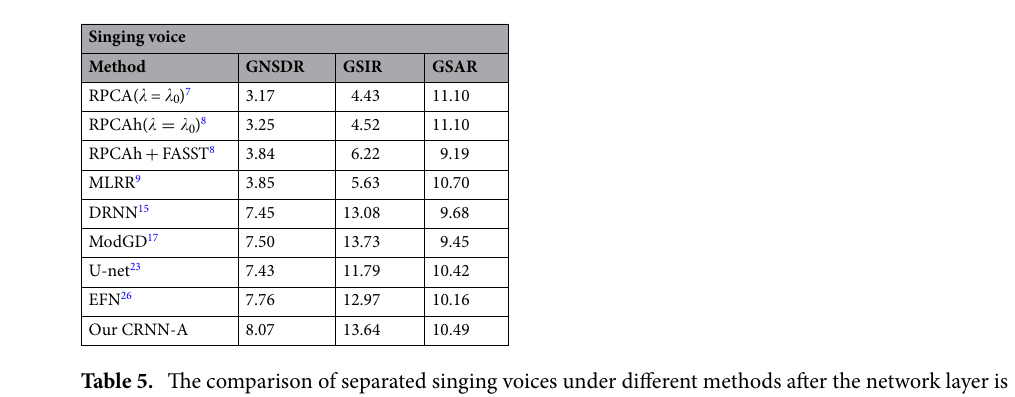
Table 5. The comparison of separated singing voices under different methods after the network layer is deepened.